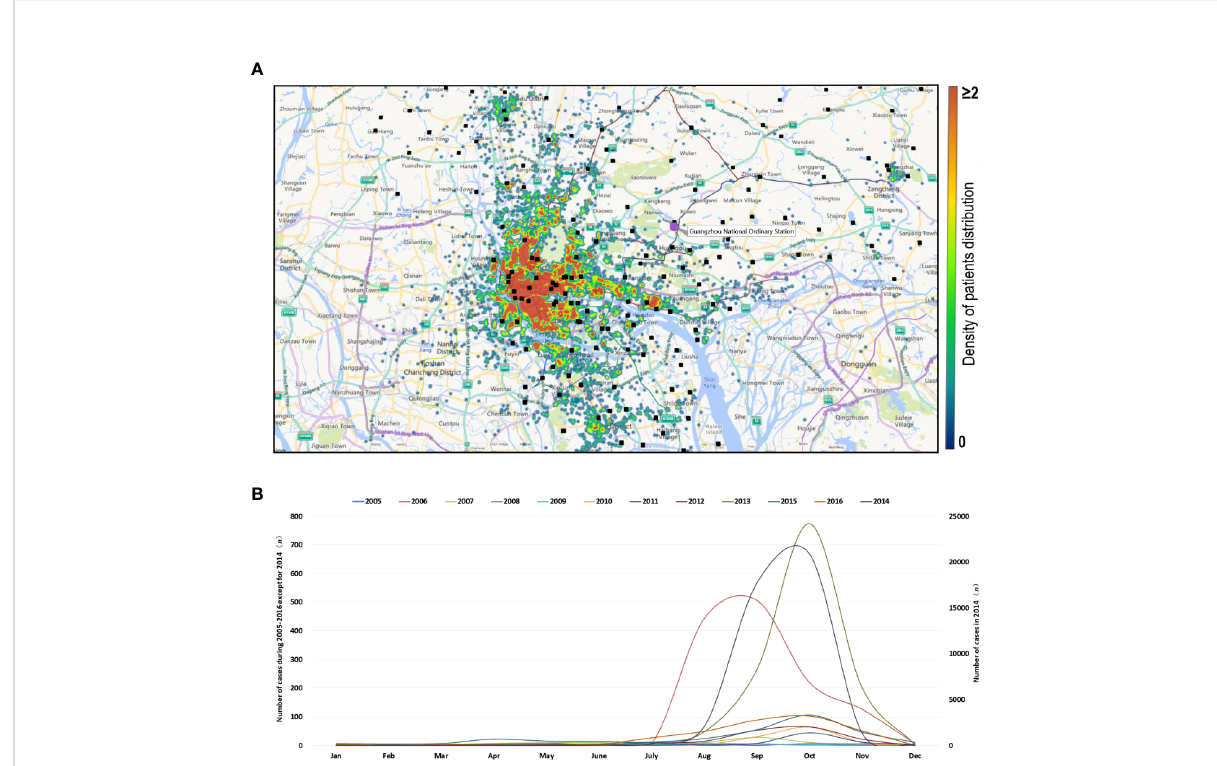
FIGURE 1 Temporal and spatial distribution characteristics of dengue cases from 2005 to 2016. (A) Accumulative spatial distribution of dengue cases from 2005 to 2016 in Guangzhou. Each patient with dengue fever reported from 2005 to 2016 represents a point, and all of the points are represented on the map. Black dots represent weather stations providing weather data. (B) Time distribution of dengue cases from 2005 to 2016. The left ordinate shows the case numbers of dengue for all years except 2014, and the right ordinate shows the case numbers of dengue in